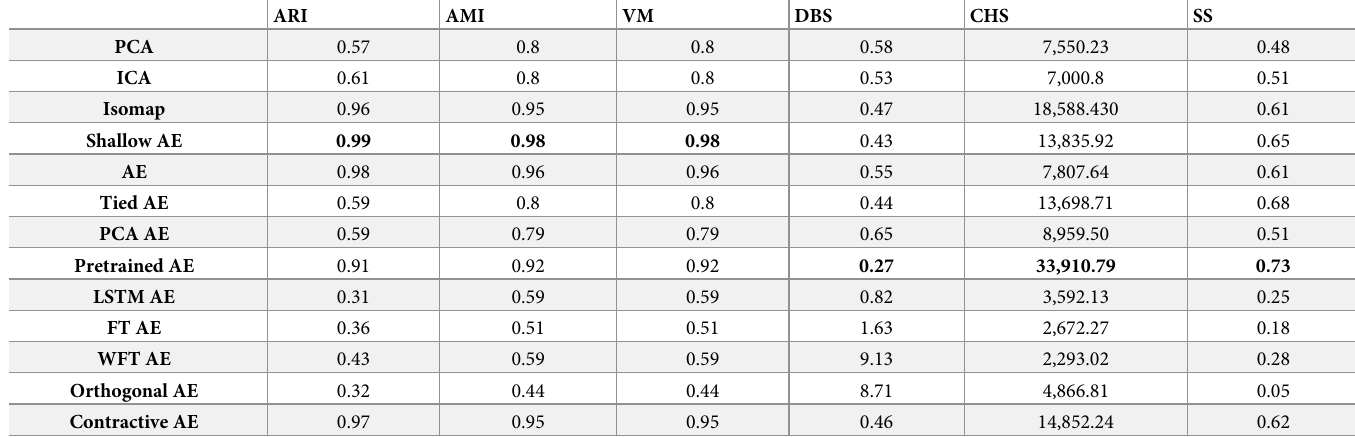
Table 5. Comparison of different autoencoder variations vs state-of-the-art methods on Sim4 (5 clusters), the optimal value of neighbours for Isomap was found as 90 through grid search. The metrics indicate that several variations of autoencoders and the Isomap algorithm are able to outperform conventional algorithms such as PCA or ICA for the Sim4 dataset that contains a low number of clusters, the values indicating the highest performance for each metric have been bolded.